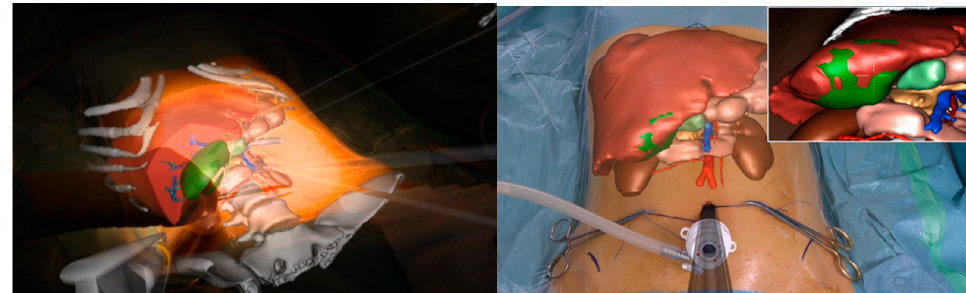
Figure 2. Projection of a virtual liver 3D reconstruction on the skin surface in relation to some exter ‐ nal landmarks. The positioning of the optical port ( left ) is guided by the inferior border of the liver and the resection planned. After the first trocar is inserted, the “see ‐ through” view will aid the op ‐ erator to place other robotic ports ( right ).